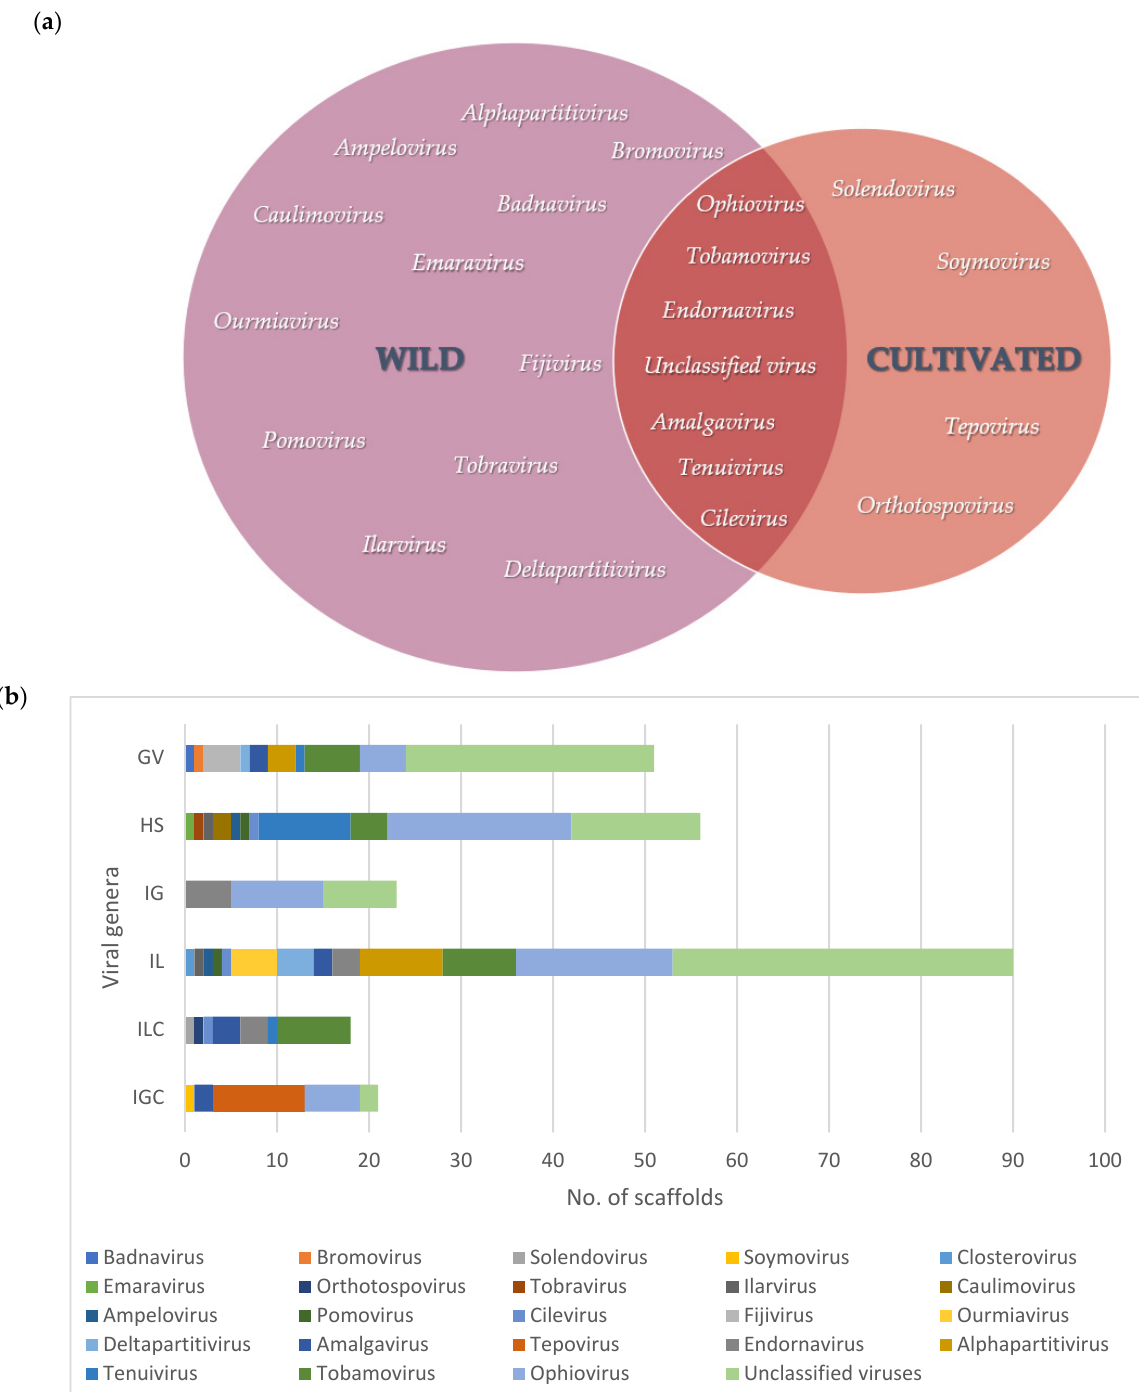
Figure 3. Viral populations in the RNA viromes of wild and cultivated V. corymbosum . ( a ) Diversity of virus sequences represented by the different range of viral genera of closely related viruses as identified by BLASTx analyses. The overlapping region indicates viral genera present in both sites. ( b ) Putative viral scaffolds with similarity to plant virus species from the different range of viral genera from each sampling location. GV, Gainesville; HS, High Springs; IL, Interlachen; IG, Island Grove; ILC, Interlachen cultivated site; IGC, Island Grove cultivated site. Unclassified viruses refer to species that have not been approved by the ICTV. Adapted from [5].